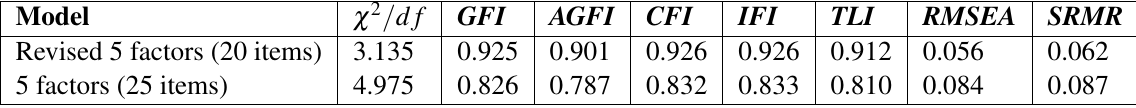
Table 3 CFA Model fitting index of the Chinese version of PHCI (n = 568) Model